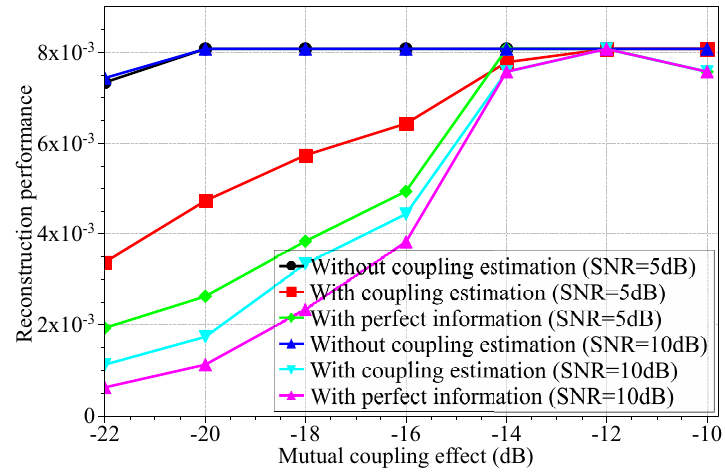
Figure 8. The reconstruction performance with and without coupling